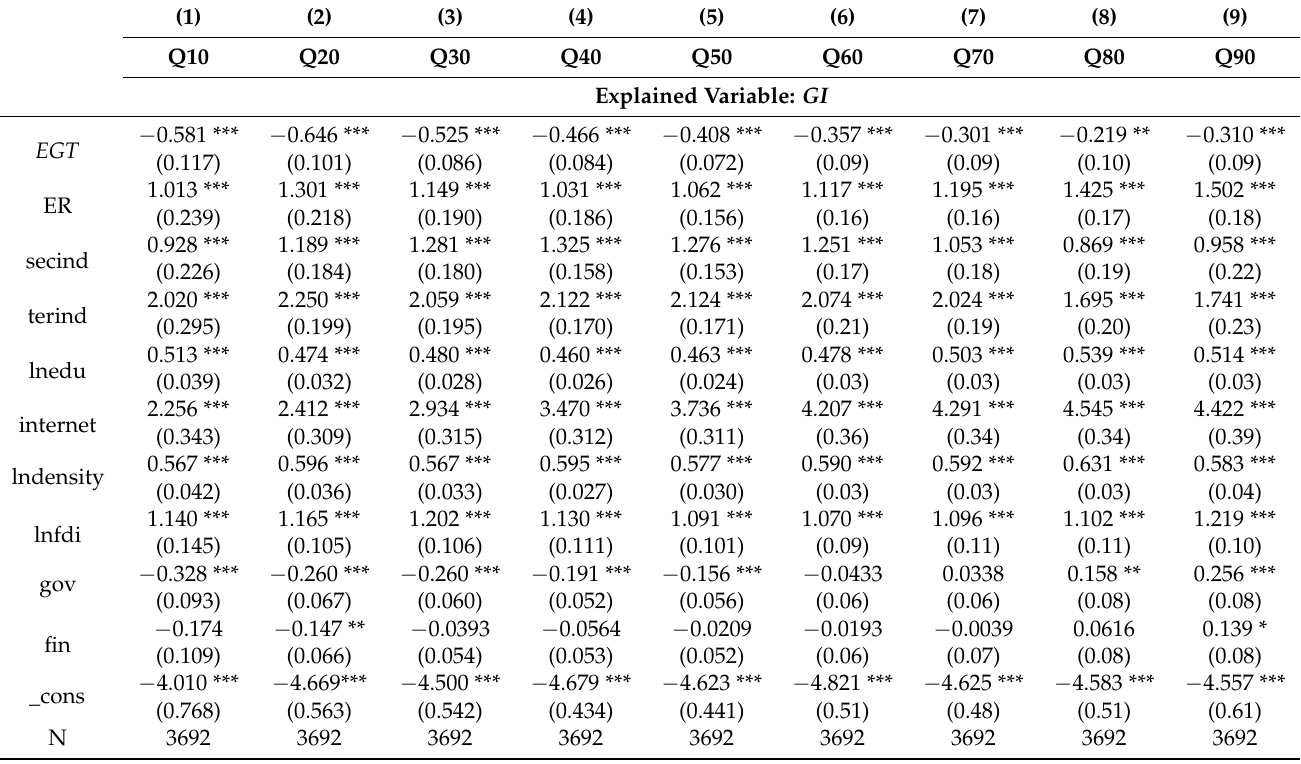
Table 6. Results of quantile regression